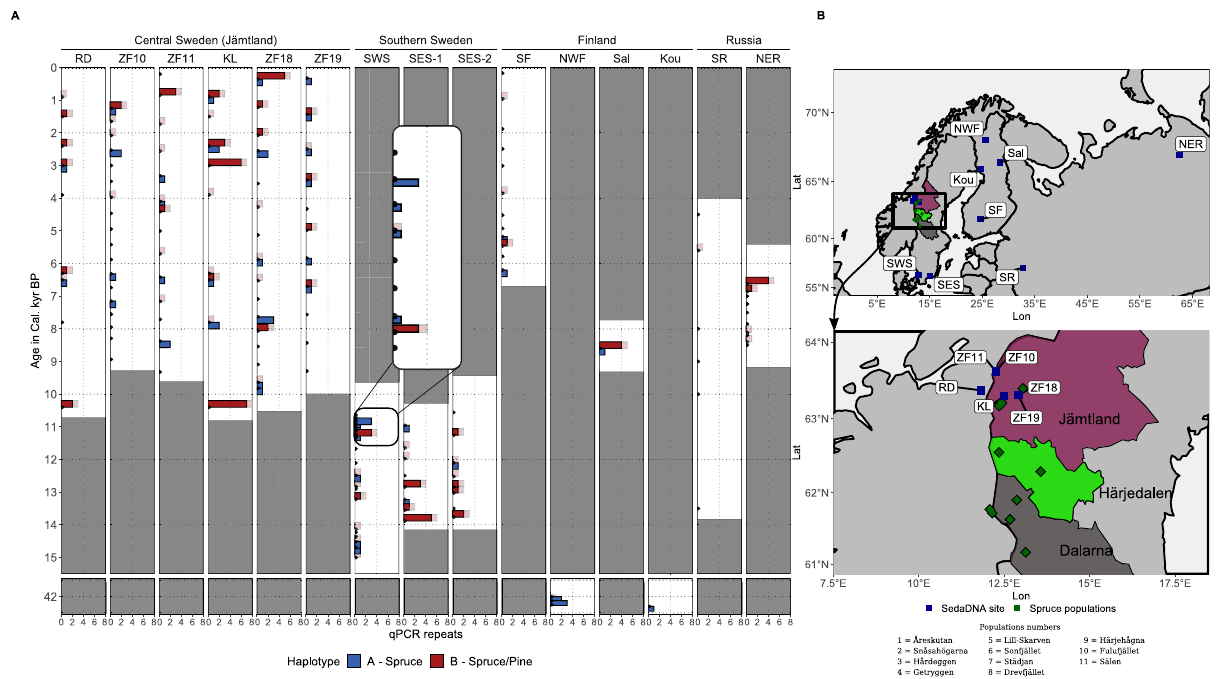
Fig. 2 Summary of sedDNA results obtained using the mitochondrial mh05 marker. A qPCR results on ancient sediments, with age on the y-axes and number of qPCR repeats on the x-axes. Mitochondrial mh05 haplotype A (blue) identi fi es only Norway spruce and haplotype B (red) identi fi es either Norway spruce or Scots pine. The transparent red bars represent haplotype B detections that are less certain due to background contamination. Black dots indicate analysed samples, and all the grey marked areas are time windows where no samples were analysed. B locations of all sites analysed: ancient sedDNA sites (blue) and modern spruce populations (green). Source data of panel A are provided as a Source Data fi le.